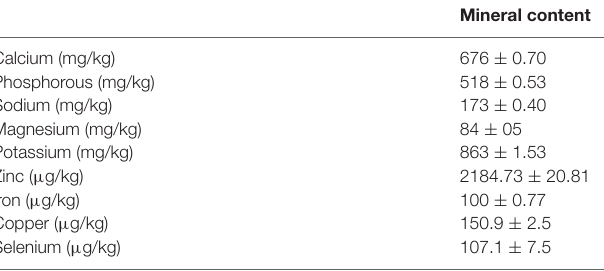
TABLE 4 | Mineral content of Zamorano-Leonese donkey fresh milk.